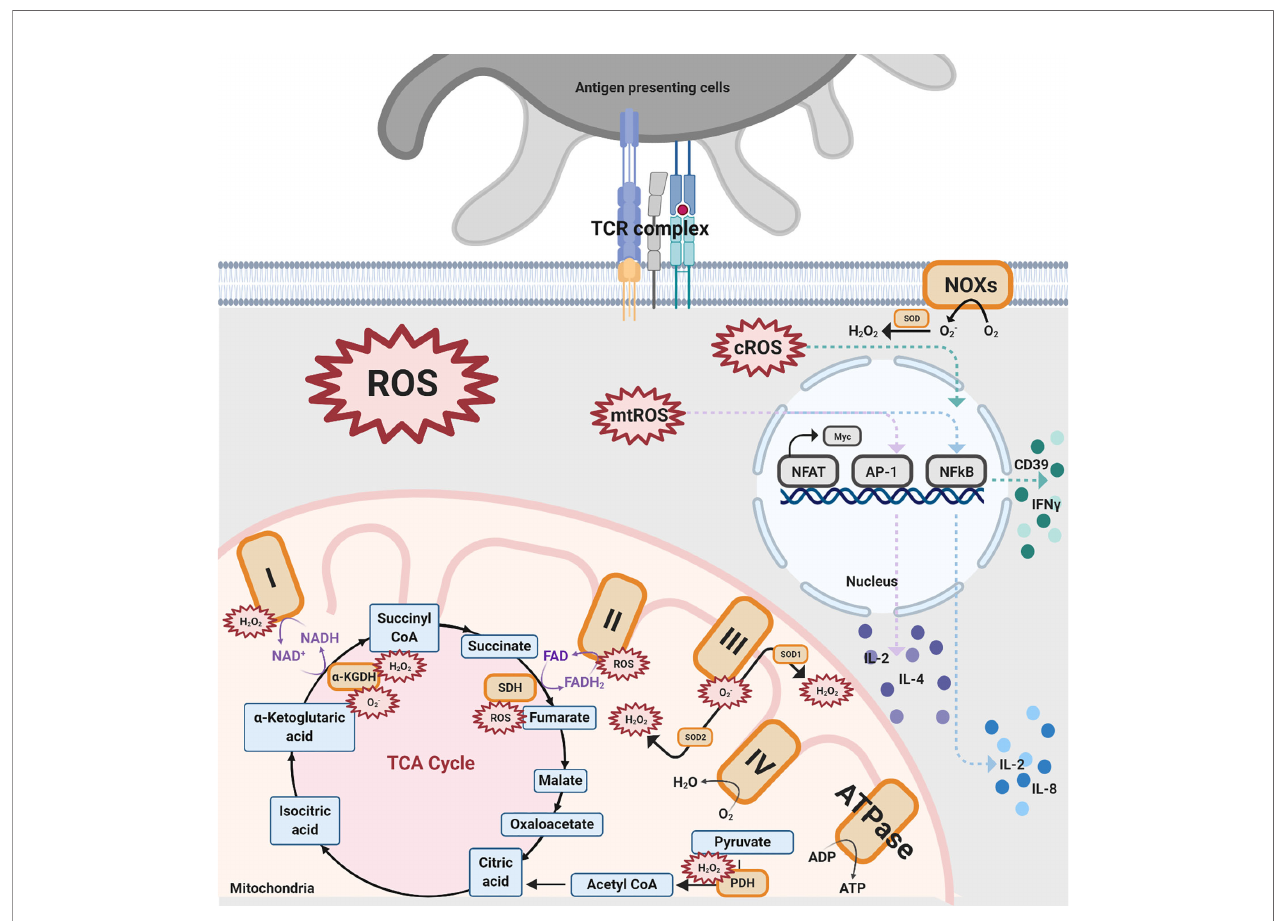
FIGURE 2 | Different sources of ROS impacting T cell activation. There are three ROS generation sources mentioned in this review that impact T cell activation: NOXs, mitochondrial complexes for OXPHOS, and TCA enzymes. NOXs are a group of enzymes responsible for the transfer of electrons from oxygen to cytoplasmic superoxide. In this fi gure, black solid arrows indicate the production of these pathways while purple solid arrows indicate the electrons transfer reactions for coenzymes within the TCA cycle and mitochondrial complexes. Colored dashed arrows designate the inductions of transcription factors, such as NFAT, AP-1, NFkB, and further upregulate various cytokines. The orange-colored box denotes protein complexes while the compounds that are produced from the TCA cycle are shown in blue. The red spiked border indicates ROS